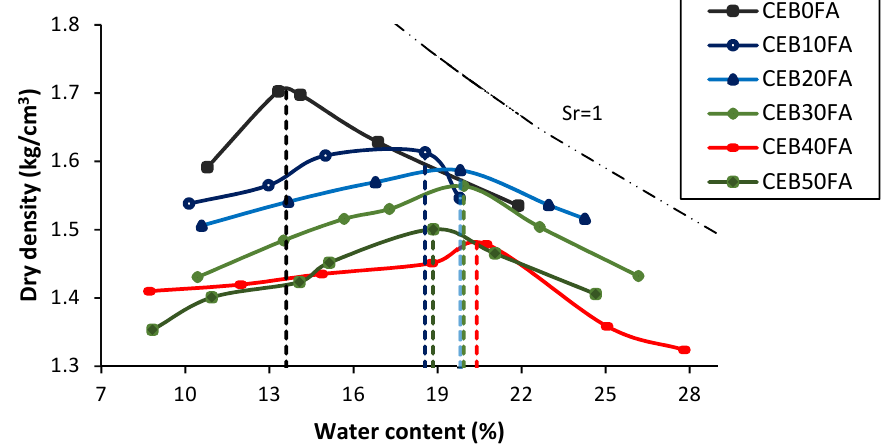
Figure 3. Optimum water content of dry mixtures.